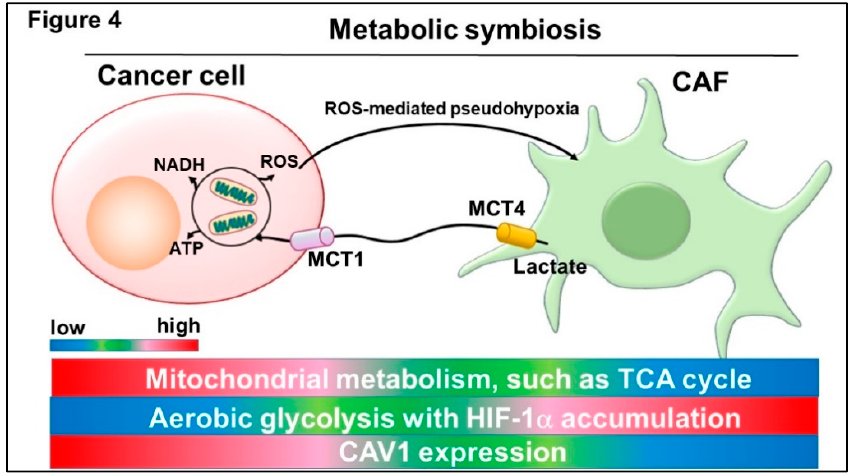
Figure 4. Metabolic symbiosis between cancer cells and CAFs requires the expression of a different MCT subtype. Monocarboxylate transporter 1 (MCT1)-expressing cancer cells induce ROS-mediated pseudohypoxia for MCT4-expressing CAFs, causing HIF-1 α accumulation in the nucleus. CAFs depend on aerobic glycolysis and secrete lactate via MCT4. Cancer cells exhibit robust lactate uptake via MCT1, allowing them to generate large amounts of ATP via the mitochondrial TCA cycle. Tumor cells then e ffi ciently produce metabolic intermediates, such as NADH by utilizing lactate derived from CAFs. ROS are a major hallmark of cancer tissues that drives robust metabolism in adjacent proliferating MCT1-positive cancer cells, which are abundant in mitochondria, mediated by the paracrine transfer of mitochondrial fuels, such as lactate, pyruvate and ketone